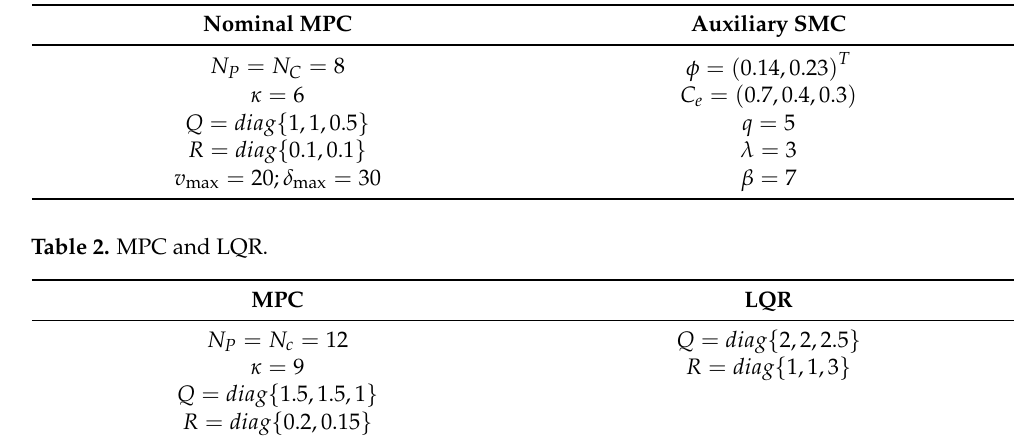
Table 1. SMC-based tube MPC.